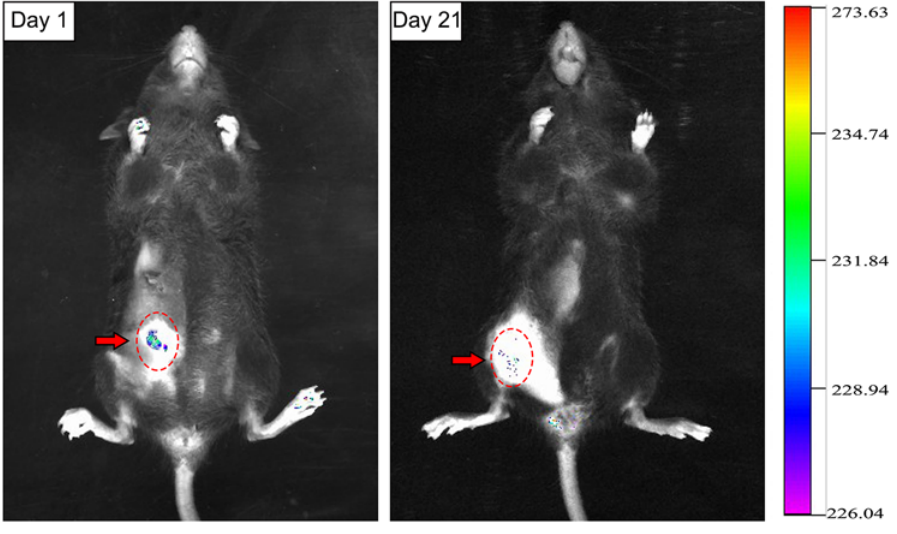
Fig 7. The retention of GFP+ adipocytes after transplantation. On Day 1 after transplantation, there was intense green fluorescent protein fluorescence (red arrow) in the injected region. On Day 21 after transplantation, there were only a few scattered regions of